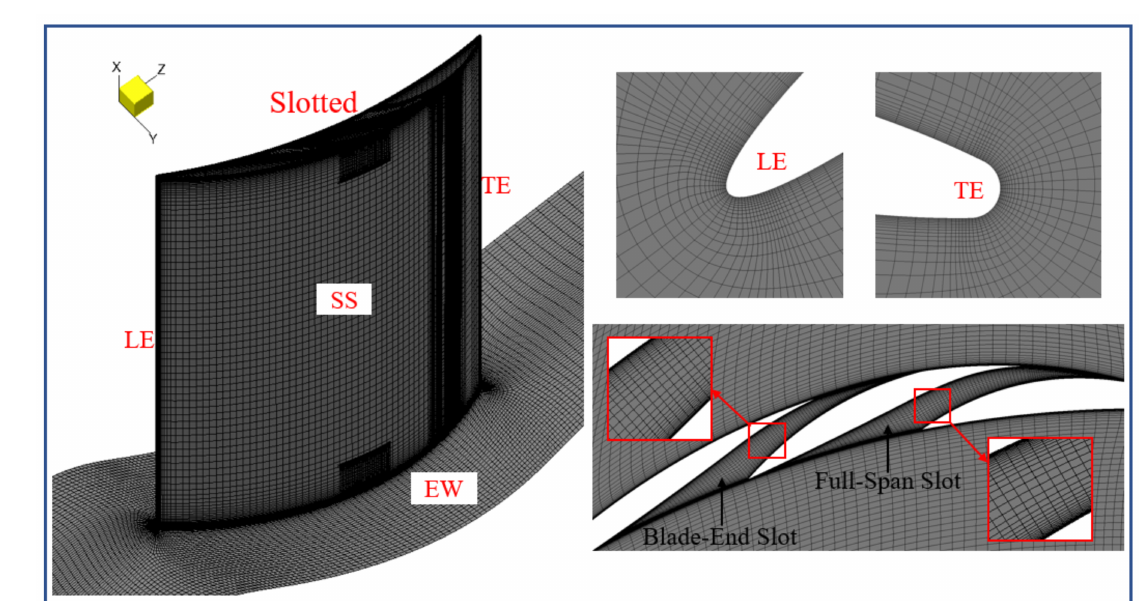
Figure 3. Overall and partial computational grid for the combined slotted